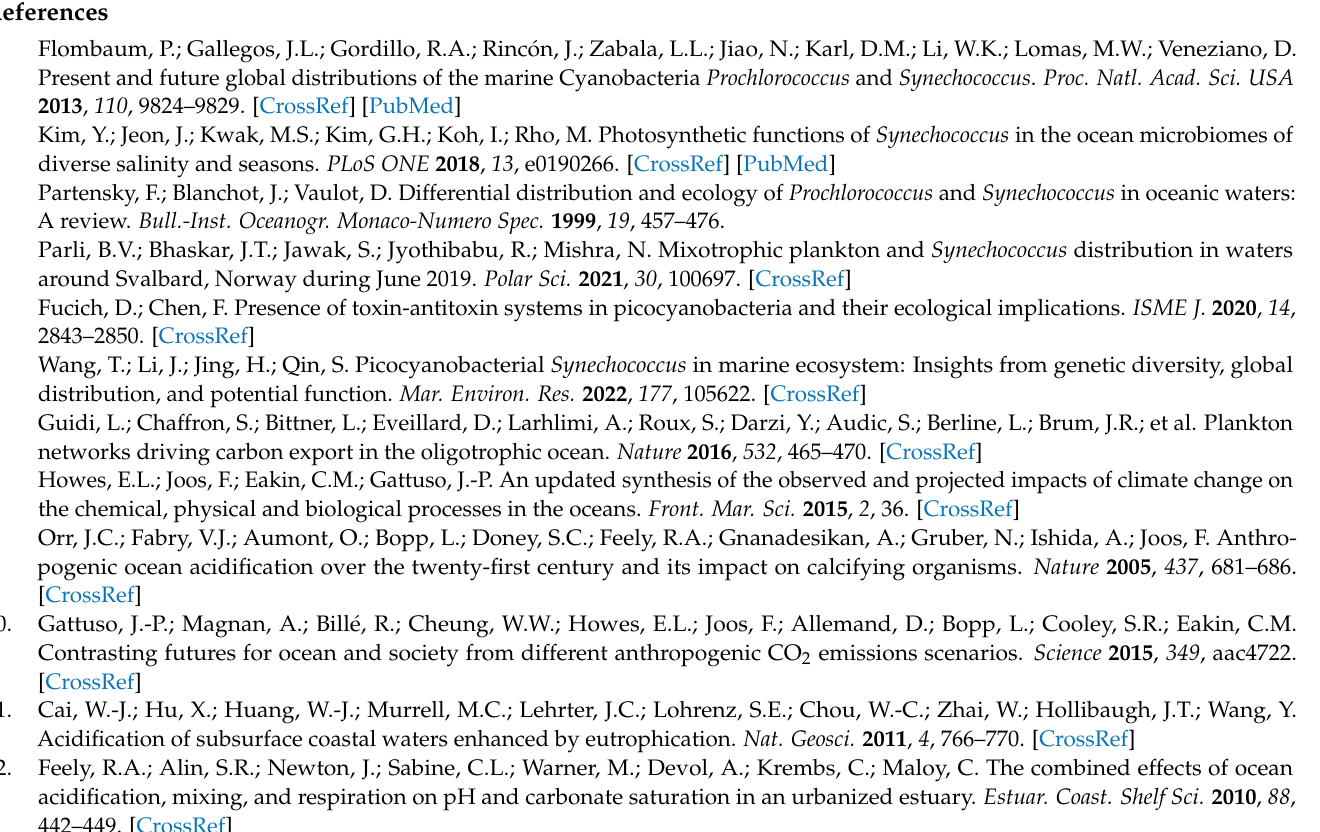
elevated p CO 2 . Table S2: The photochemical parameters derived from rapid light curves (Figure S2) of Synechococcus cells grown under different p CO 2 and light combinations. Table S3: Statistical analyses of physiological traits of Synechococcus CB0101 grown under different p CO 2 and light combinations. Table S4: Percentage inhibition of carbon fixation under elevated p CO 2 under different light levels. Figure S1: Rapid light curve (RLC) of Synechococcus CB0101 grown under different light levels combined with the ambient or elevated p CO 2 . Figure S2: An example of decomposition of the absorption spectra a*( λ ) by a series of Gaussian curves. Figure S3: Particulate organic carbon (POC) and nitrogen (PON) production rates of Synechococcus CB0101 grown under different p CO 2 and light combinations. Figure S4: PCA analysis of rETR vs Irradiance data from Figure S1 for all